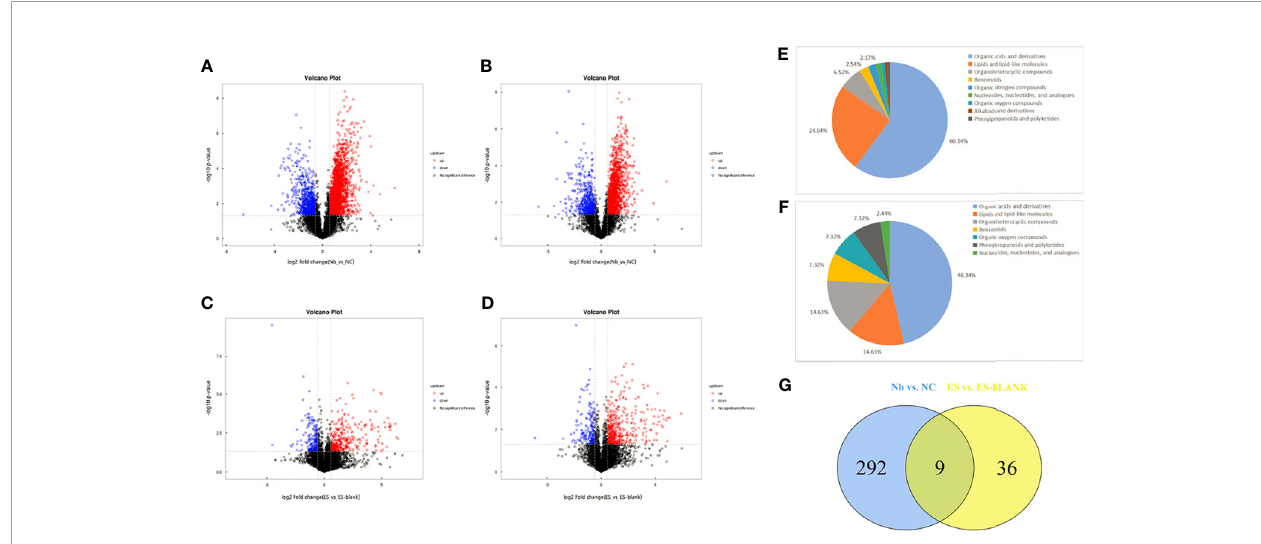
FIGURE 2 | Unique and common differential metabolites in Nb vs. NC and ES vs. ES-blank groups. The volcano maps of differential metabolites of positive (A, C) and negative (B, D) ion modes. Red scatters denote the upward trend in metabolites, blue scatters indicate the downward trend in metabolites, and black scatters show the non-signi fi cant trend in metabolites. The chemical classi fi cation chart of distinct metabolites in the Nb (E) and ES groups (F) as well as common and unique metabolite distribution within the two sample groups (G) . Different colors in the picture indicate distinct chemical classi fi cations. Percentage represents the proportion of the metabolite number in the chemical classi fi cation to the total metabolite number. The Venn diagram shows the overlap of the signi fi cantly different metabolites. Two circles were used to denote the clustering of the entire distinctly expressed metabolites into two comparison groups. The number of distinctly expressed metabolites in one comparison group was taken as the sum of the entire fi gures represented in one